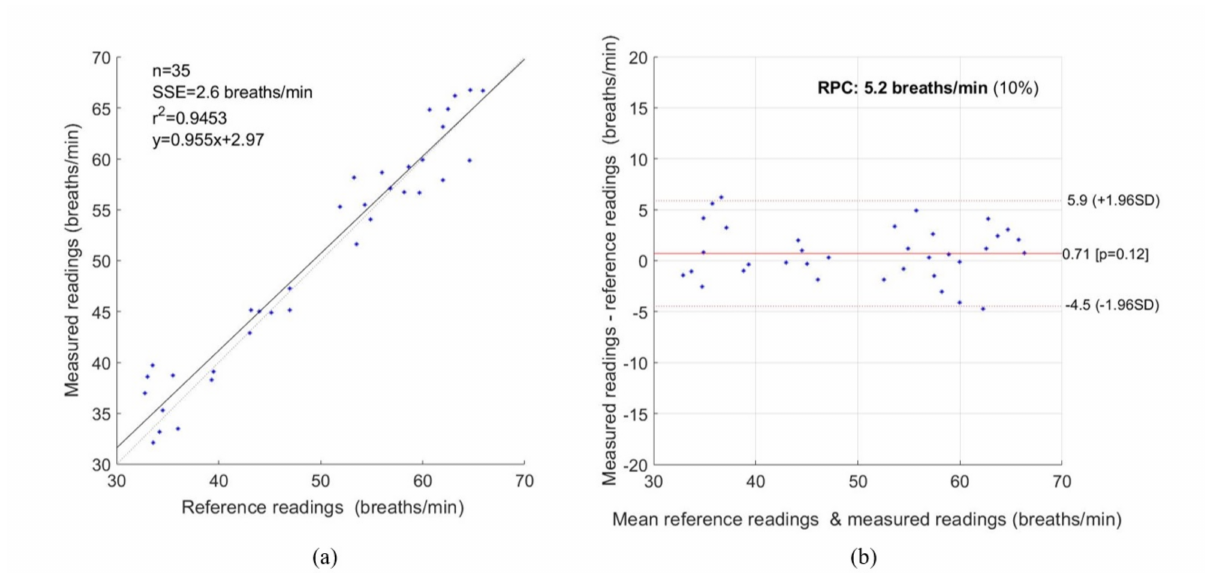
Figure 12. Statistical measurement for RR. ( a ) Correlation Plot, ( b ) Bland–Altman plot.